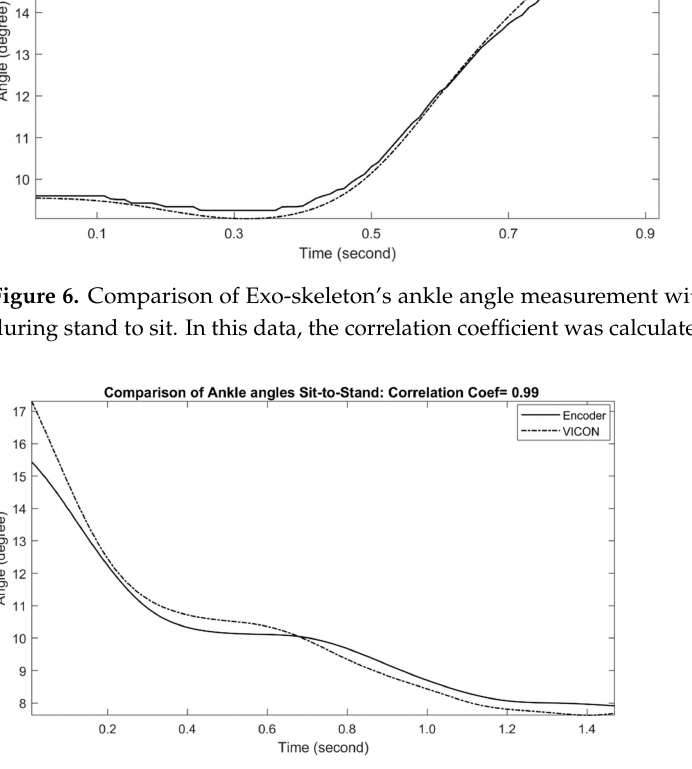
Figure 7. Comparison of Exo-skeleton’s ankle angle measurement with reference motion capture during sit-to-stand. In this data, the correlation coefficient was calculated at 0.99.